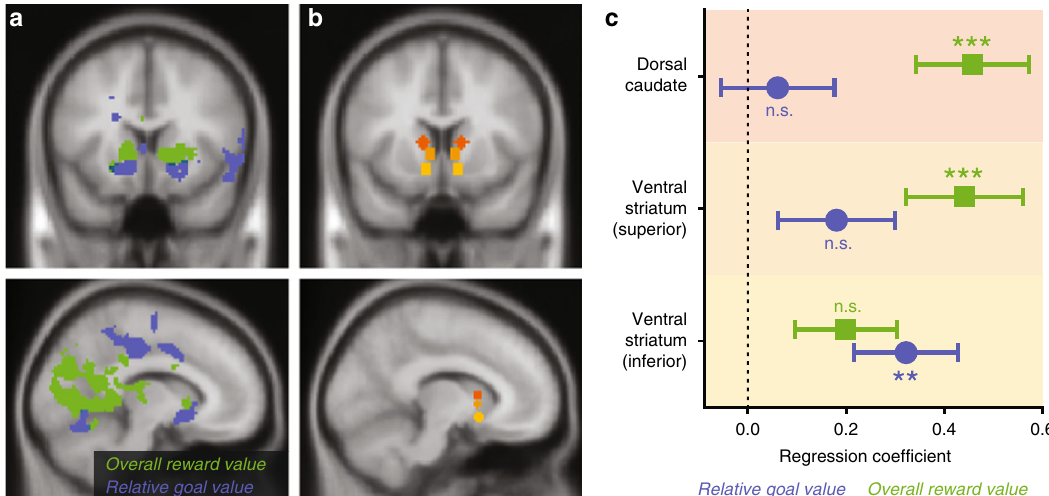
Fig. 3 Reward and goal value dissociate across the striatum ’ s dorsal-ventral axis. a Whole brain results for relative goal value (blue) and overall reward value (green), thresholded at voxelwise p < 0.001 and cluster-corrected p < 0.05. Despite being correlated with activity in our a priori value network ROI, overall goal value did not survive the whole-brain threshold used for these follow-up exploratory analyses. b To interrogate our fi ndings across regions of striatum, we selected independent bilateral ROIs previously used as seeds for distinct resting-state networks: 49 Dorsal Caudate (dark orange; [x, y, z] = ±12, 10, 8), Ventral Striatum, superior (orange; ±8, 10, 1), and Ventral Striatum, inferior (yellow; ±10, 11, − 9). c Mixed-effects regression coef fi cients across these ROIs demonstrate a dorsal-ventral dissociation, with dorsal regions more sensitive to overall reward value and the ventralmost region more sensitive to relative goal value. Error bars show standard error of the mean. ** p < 0.01, *** p <